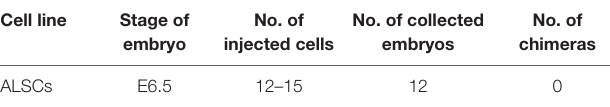
TABLE 1 | ALSCs do not contribute to E6.5 chimera by injection to